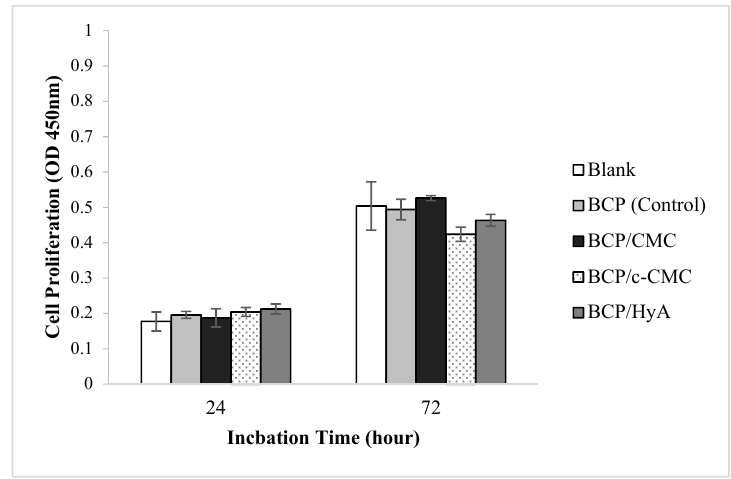
Figure 7. Cytotoxicity of the four graft materials to MG-63 osteoblast-like cells. No evidence of cytotoxicity was observed. Blank, no specimen added ( n = 5).